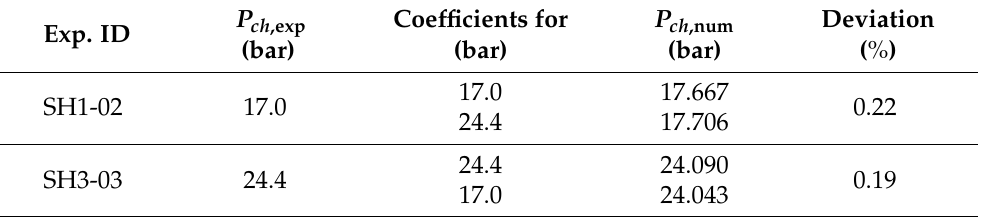
Table 9. Effect on P ch ,num when applying incorrect product